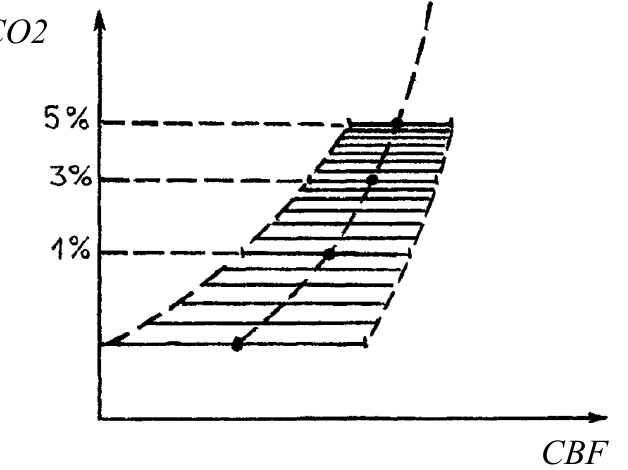
Fig. 3. Dispersion of CBF indicators as the response to the increasing of CO2%